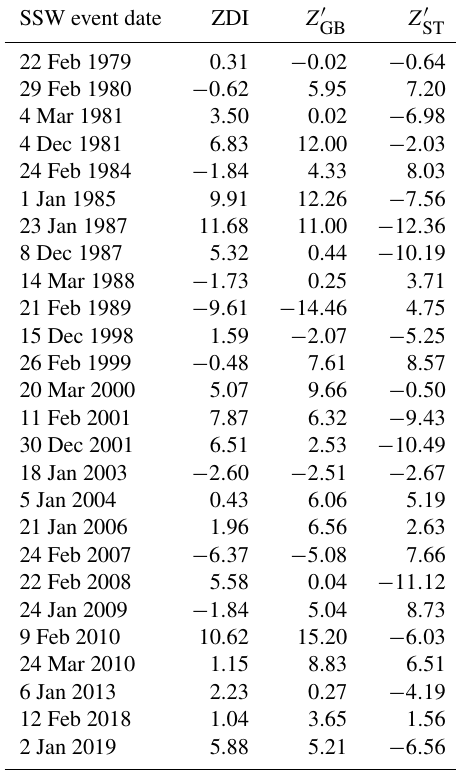
Table 1. List of observed SSW events in ERA-Interim reanalysis and their corresponding ZDI, Z (cid:48) averaged over a period of 30d following the SSW central